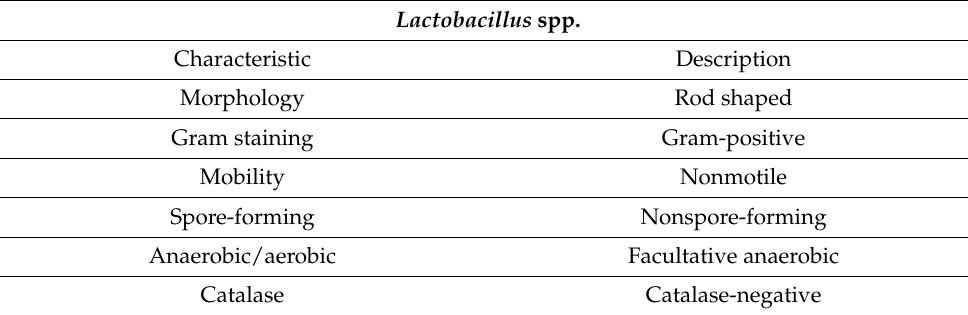
Table 4. Characteristics of Lactobacillus